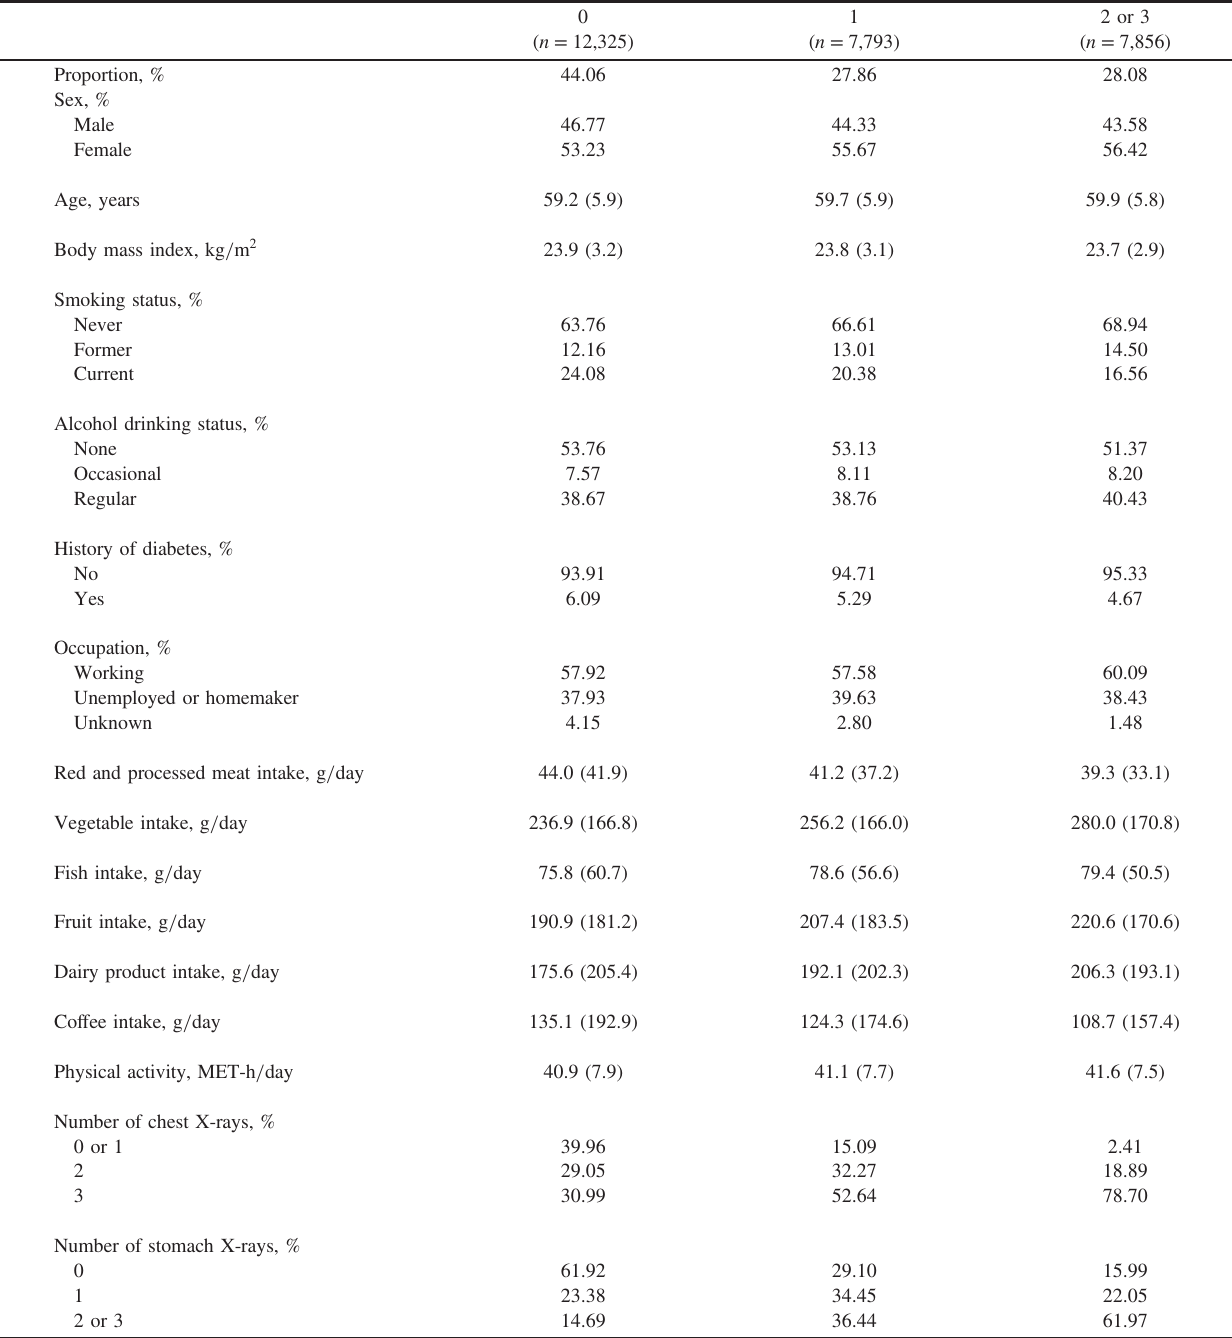
Table 1. Characteristics of study subjects at the start of follow-up according to the number of FOBTs 0 1 2 or 3 ( n = 12,325) ( n = 7,793) ( n =